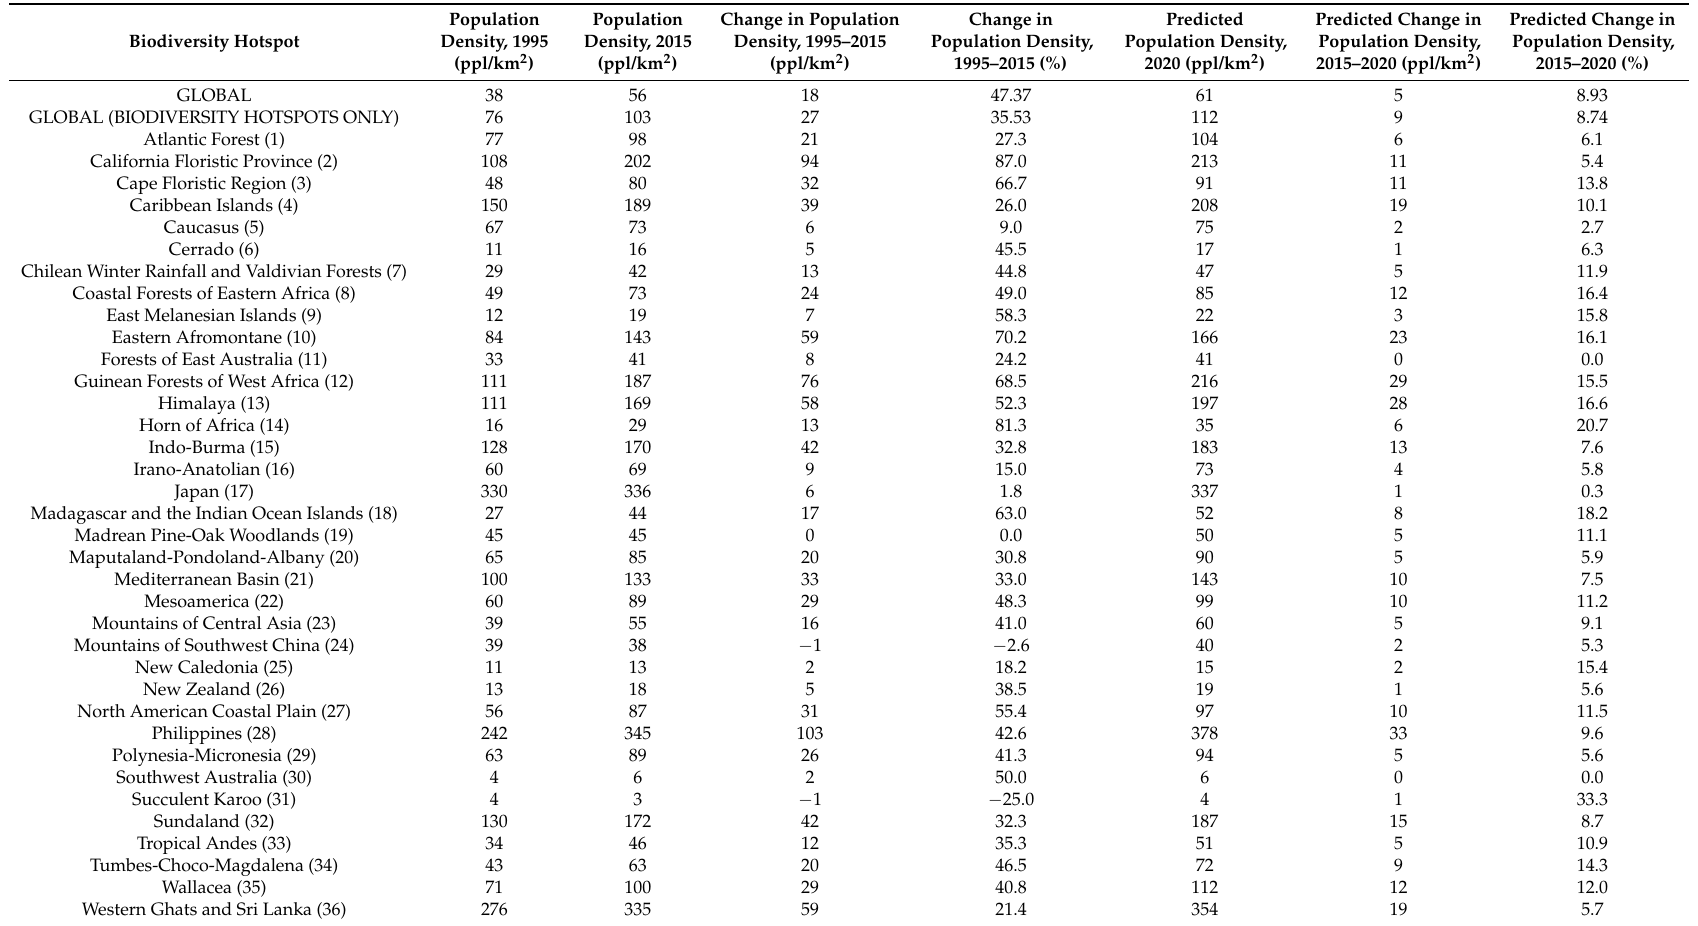
Table A1. Population Density Data for each Biodiversity